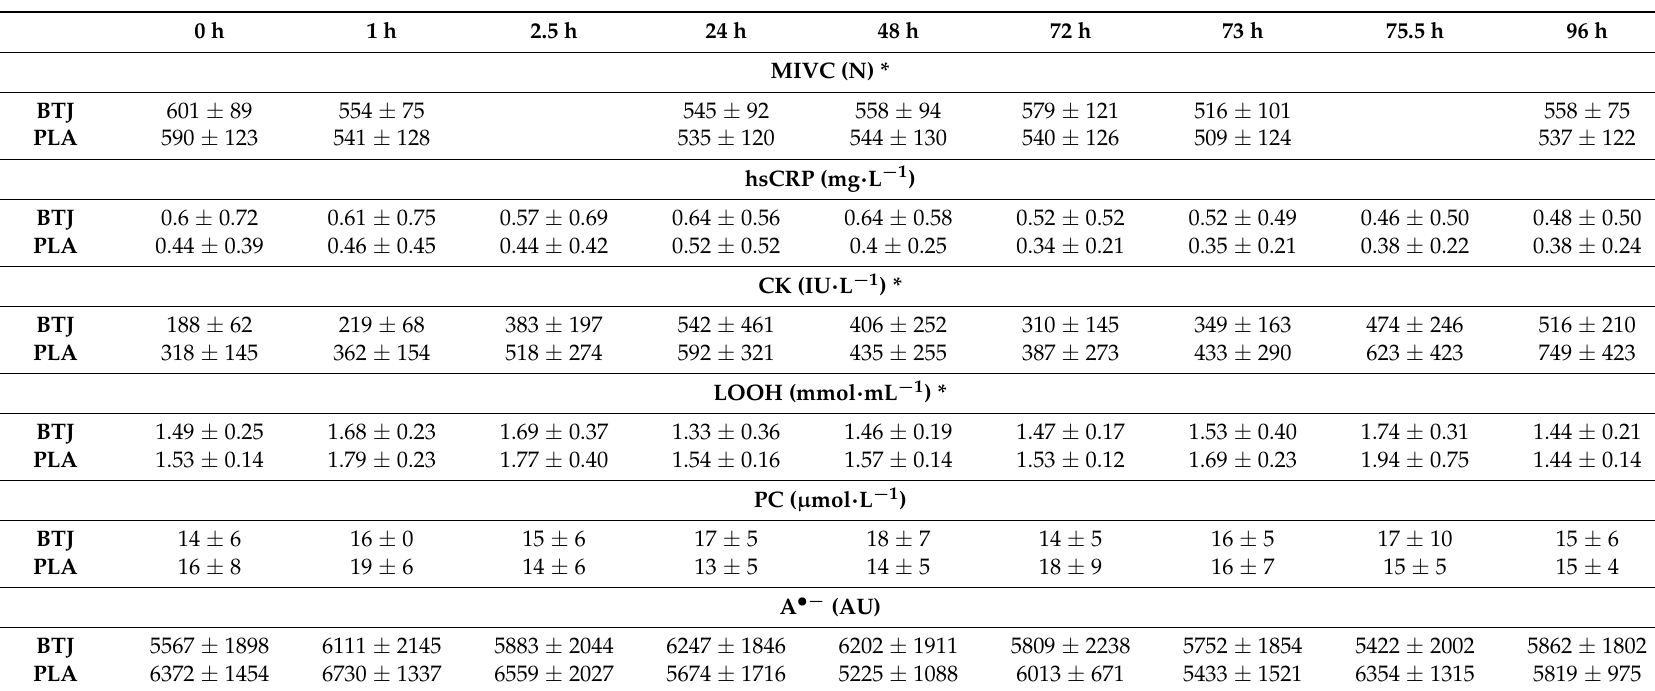
Table 5. Maximal isometric voluntary contractions (MIVC), high sensitivity-C-reactive protein (hs-CRP), creatine kinase (CK), lipid hydroperoxides (LOOH), protein carbonyls (PC) and plasma ascorbate free radical (A •− ) for the beetroot juice (BTJ) and placebo (PLA) group’s pre-RST1 (0 h)—96 h